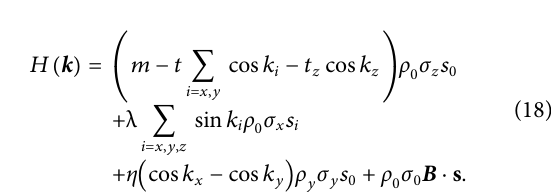
Frontiers in Physics |